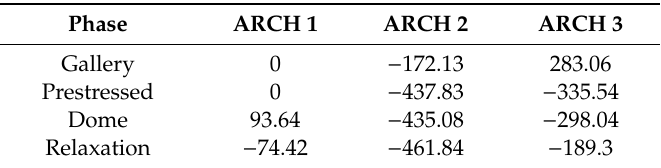
Table 22. Compression in arches (kN).